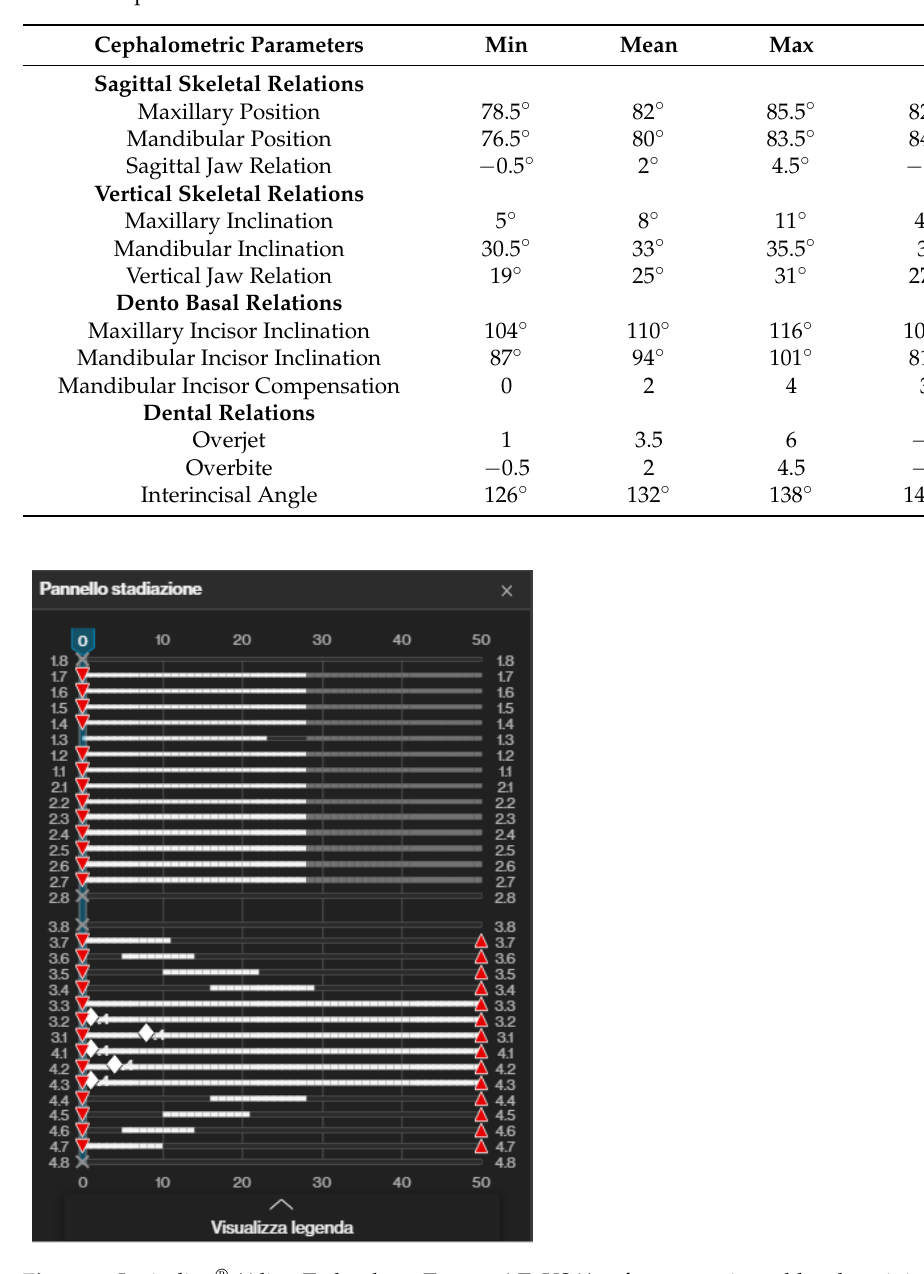
Table 1. Cephalometric values before treatment.